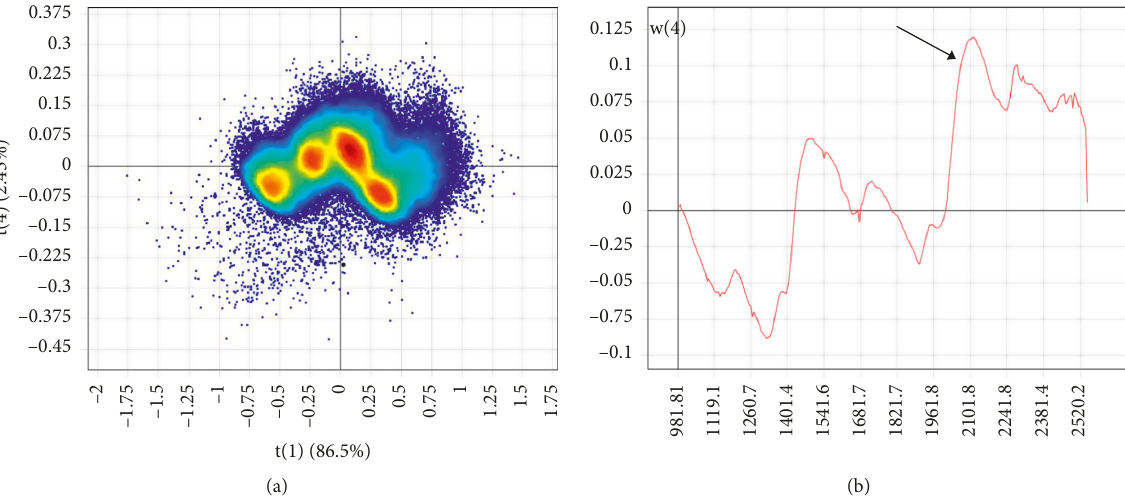
Figure 9: (a) Score plot of PC4 versus PC1 for the two thermal modification processes and (b) loadings for PC4 in PLC-DA model. The arrow shows the greatest difference in the spectral